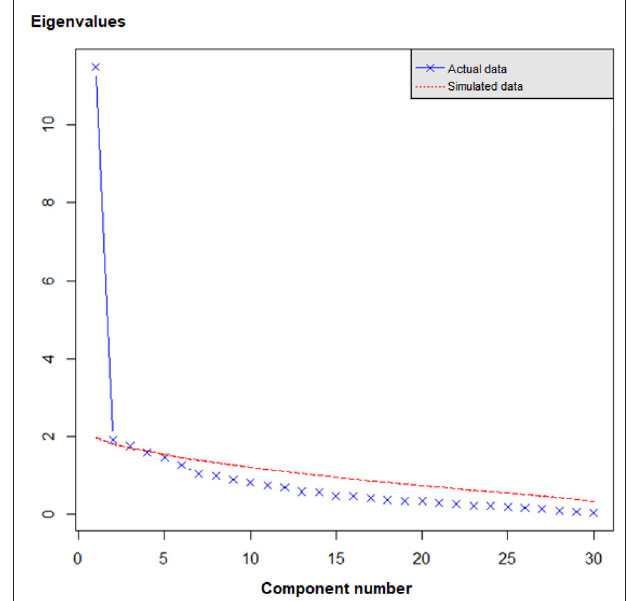
FIGURE 1 | Scree plot. Actual data: unimputed complete case observed data from set A. Simulated data: simulated random data from Monte Carlo Parallel Analysis. The strongest inflection in the empirical data is observed after the first component, suggesting unidimensionality. The lines cross between component 3 and 4, indicating that three components based on actual observed data provided more substantive information compared to three components based on purely random data. Four or more components should therefore not be extracted from the observed